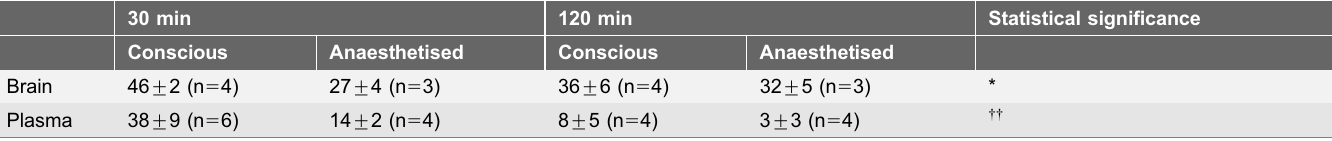
Table 2. Percentage of parent compound detected in rat brain and plasma samples at 30 and 120 min following injection of [ 125 I]WYE-230949. 30 min 120 min Statistical significance Conscious Anaesthetised Conscious